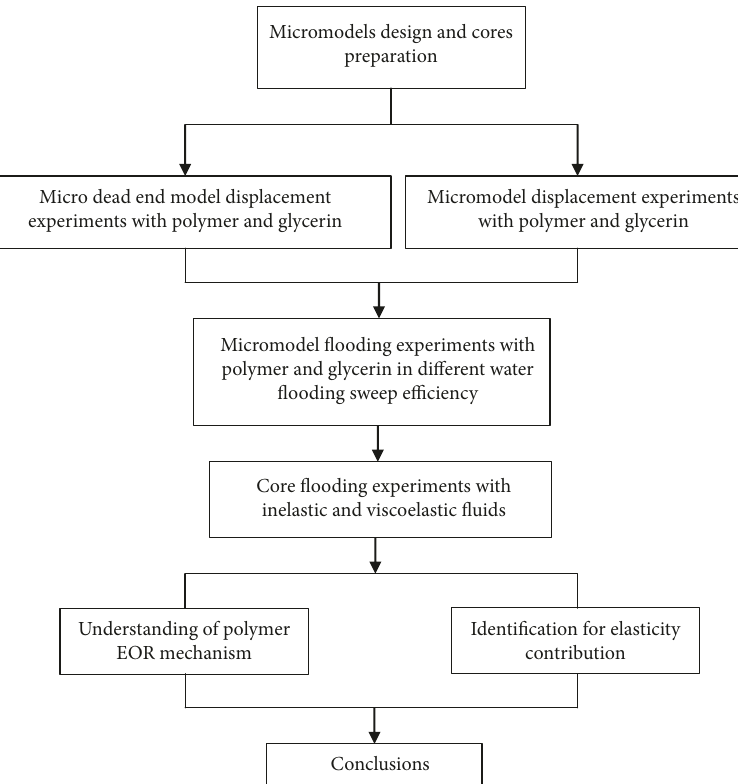
Figure 1: General sketch of this experimental